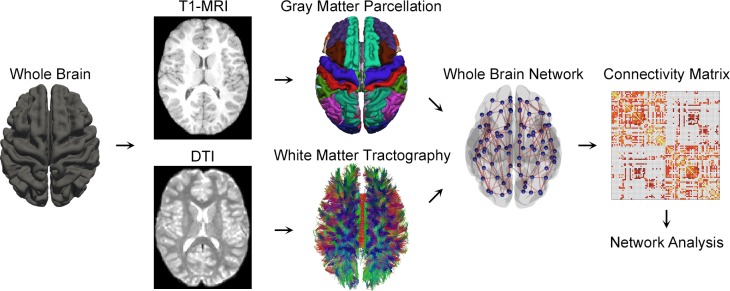
Diagram of the brain network analysis.T1-weighted anatomical MRI scans of each individual were used to parcellate the cortex into 144 brain regions, forming the nodes of a brain network. Whole brain fiber tractography was applied to the DTI scans to reconstruct white matter pathways connecting pairs of brain regions, and the network edge was defined by the fiber density between the regions. The structural network was constructed in the form of a 144 × 144 weighted symmetric connectivity matrix. The topological organization of the resulting brain networks, including the correlations with blood glucose level (HbA1c and FPG), was investigated for 20 persons with type 2 diabetes and their age- and sex-matched controls.